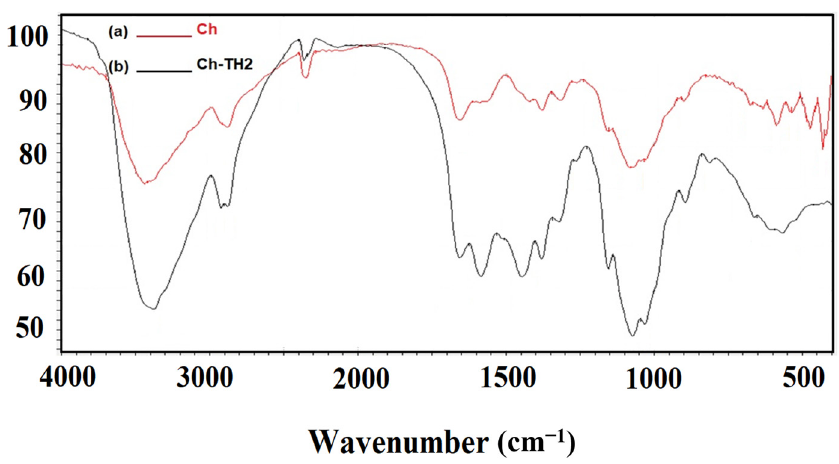
Figure 2. FTIR spectra of ( a ) chitosan and ( b ) HCh-TH2.